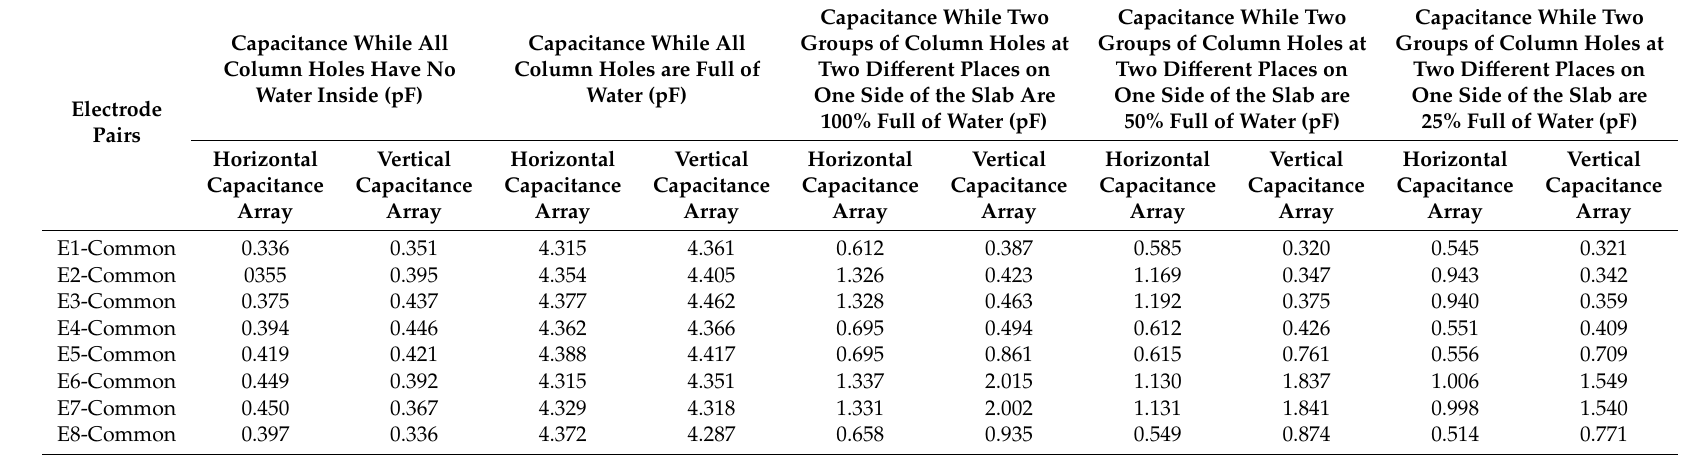
Table 2. The measured capacitances between di ff erent electrode pairs while two groups of column holes at two di ff erent places on one side of the slab are full of di ff erent quantities of water.